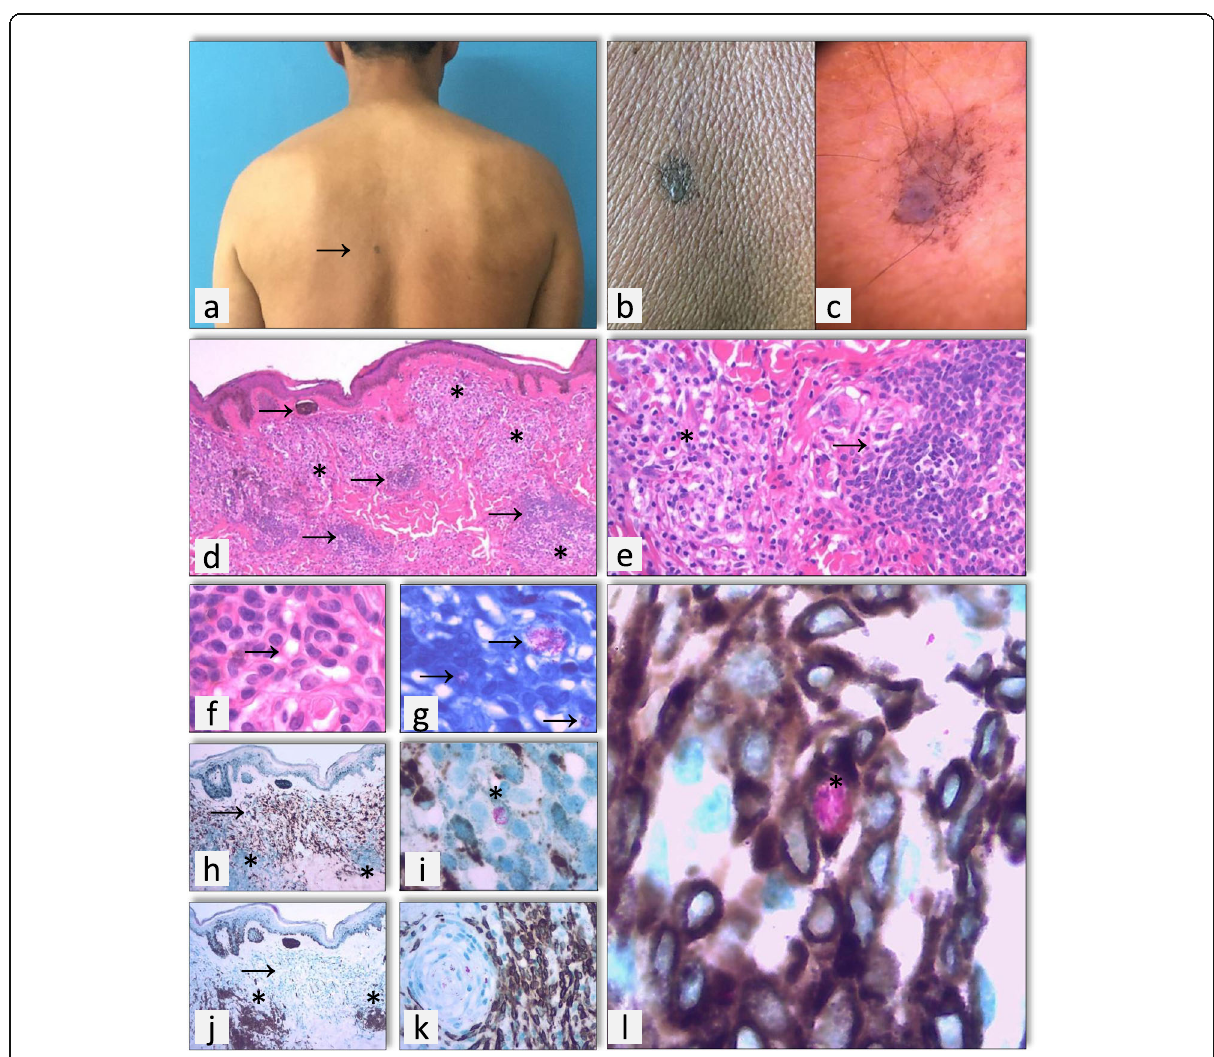
Fig. 1 Parasitism of melanocytic nevus by M. leprae in case 1. a and b Nevus lesion in the dorsum of a patient with leprosy BL. c Dermatoscopy showing the nevus lesion and adjacent skin without characteristics of a leprosy lesion. d and e Histological sections showing compound melanocytic nevus ( → ) and leprosy lesion (*) permeating nevus cells (HE). f and g Vacuolated nevus cells (HE) containing bacilli (FF) ( → ). h and i Double staining (IHC-CD68 and FF) showing leprosy lesion macrophages stained ( → ) and non-stained nevus cells (*) containing bacilli in the cytoplasm. j and k Double staining (IHC-Melan A and FF) showing non-immunostained leprosy lesion ( → ) and immunostained nevus cells (*), both containing bacilli in the cytoplasm. l Double staining (IHC-Melan A and FF) showing immunostained nevus cells (*) containing bacilli inside the intracytoplasmic